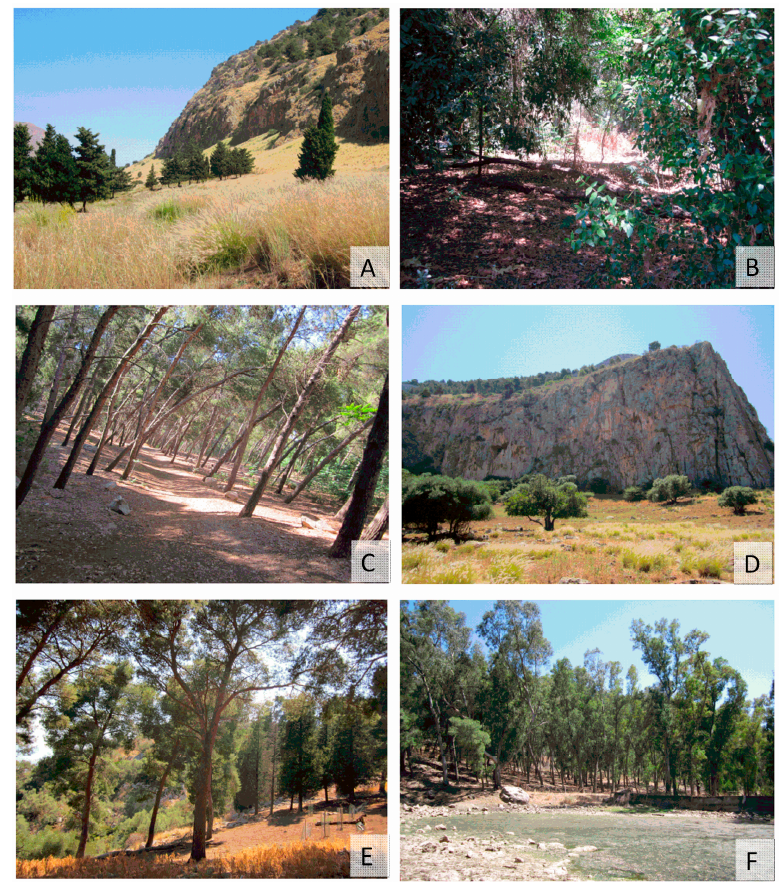
Figure 2. ( A – F ) Collection sites in the Natural Reserve of Monte Pellegrino monitored in this